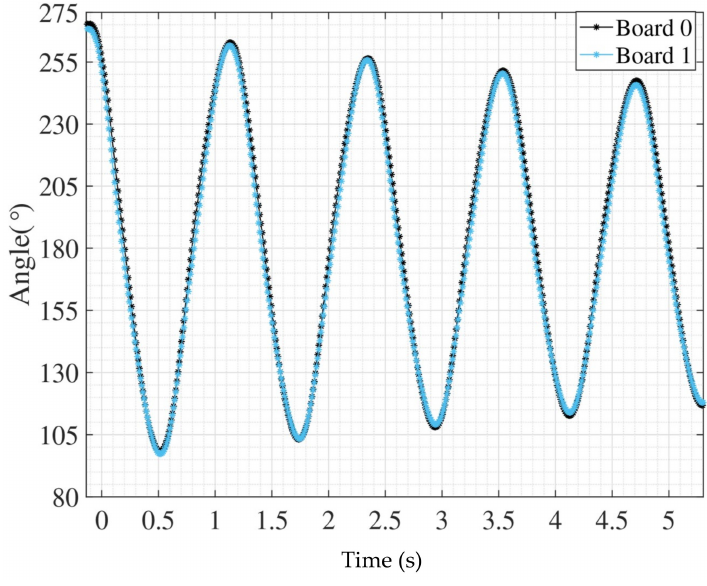
Figure 8. Oscillations recorded by two sensors attached to a pendulum.